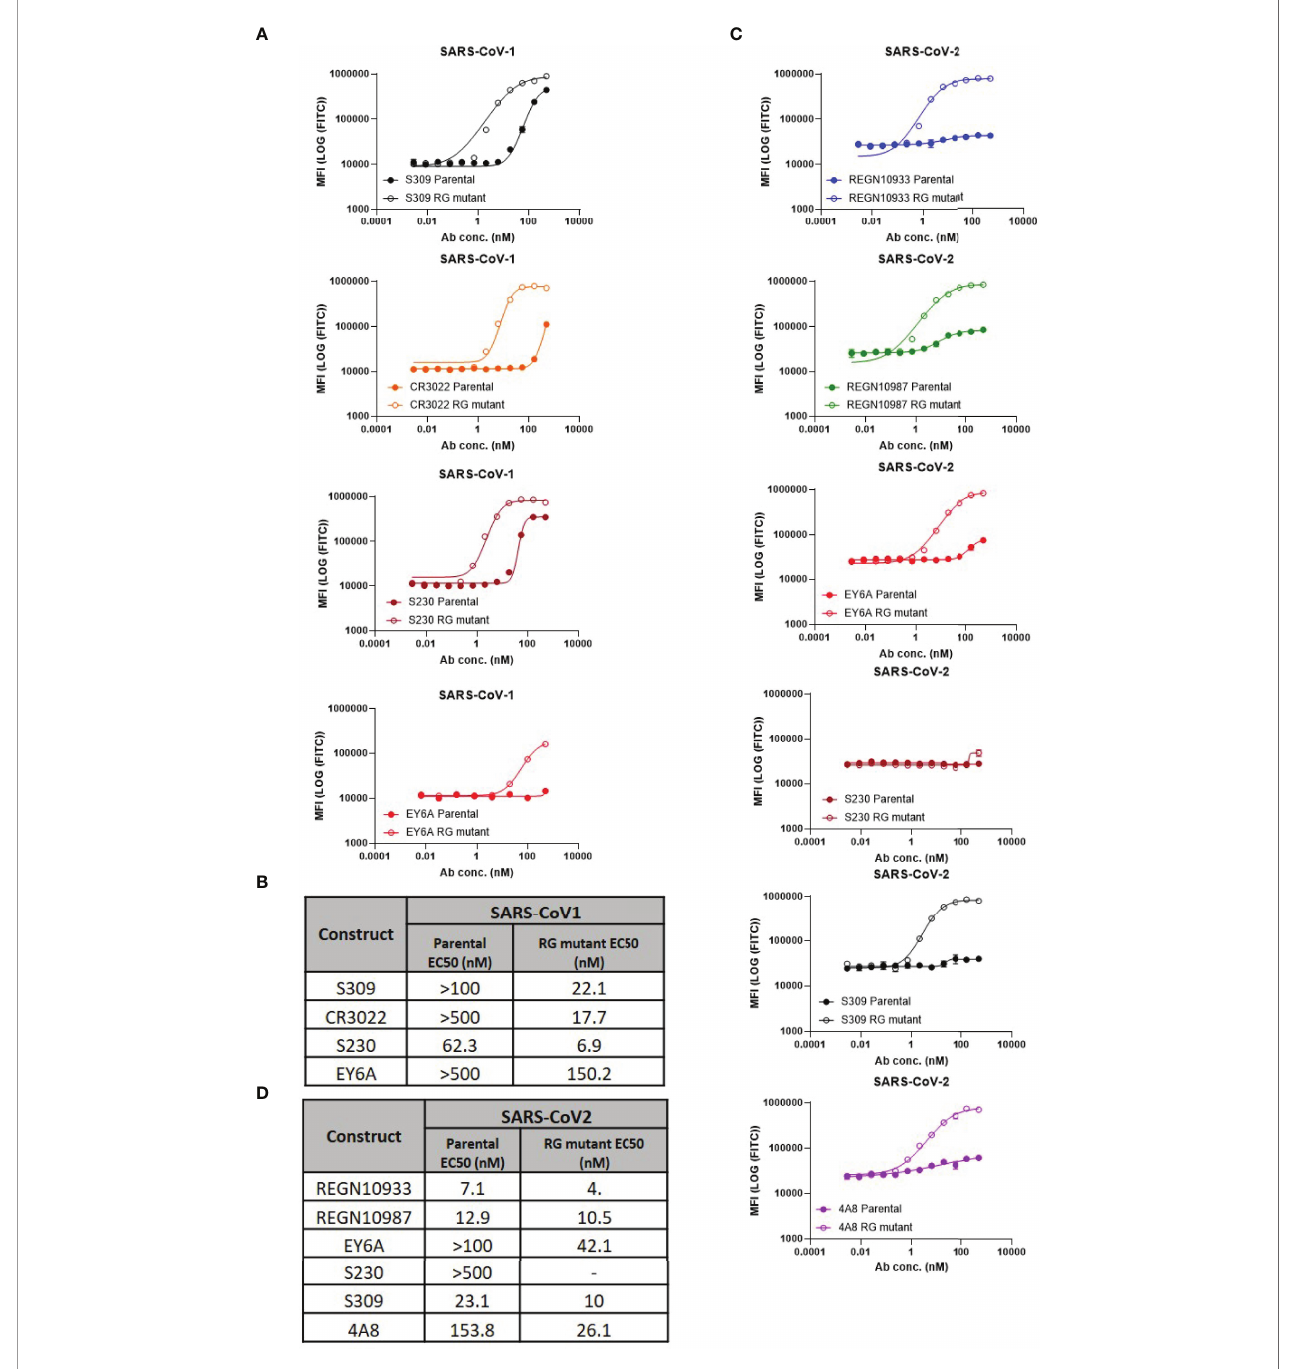
FIGURE 1 | Hexamer formation detected using FACS-based C1q binding assay. (A) Comparison of C1q binding of parental vs antibodies with RG mutant mAbs on SARS-CoV-1 cell lines (mean values with SD; n=3; EY6A graphs contain mean values only), (B) Calculated EC50 values of RG mutant vs parental, (C) Comparison of C1q binding of parental vs antibodies with RG mutants on SARS-CoV-2 cell lines (mean values with SD; n = 3), (D) Calculated EC50 values of RG mutant vs